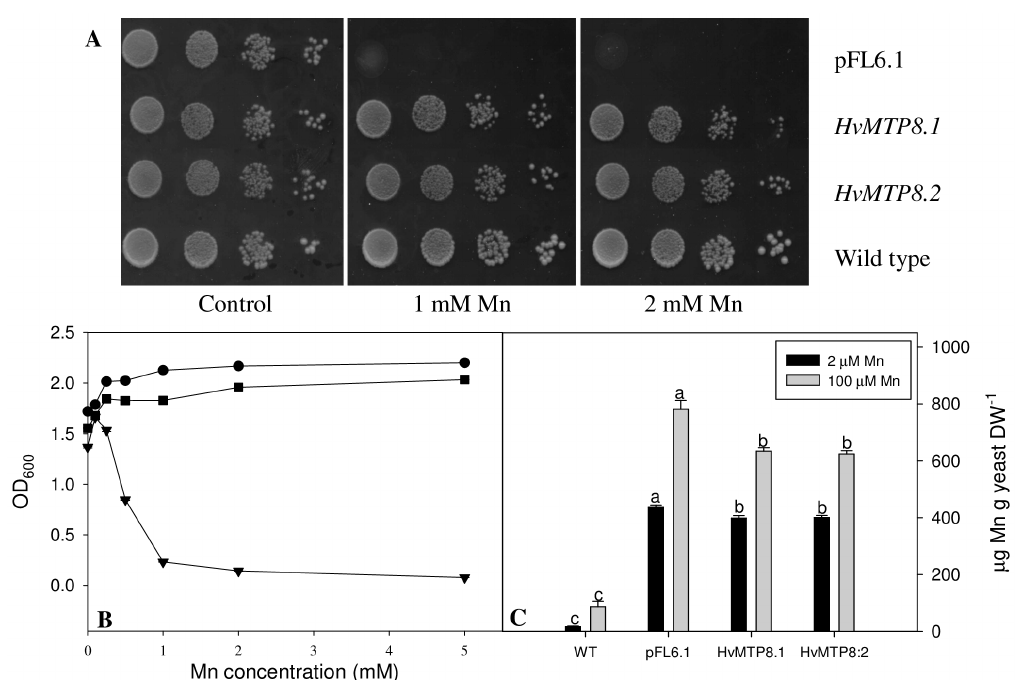
Fig. 2. Effect of MTP8.1 and MTP8.2 expression on Mn 2 + tolerance and Mn accumulation in the yeast mutant pmr1 D . Serial dilutions (1.0, 0.1 and 0.01 OD 600 ) of pmr1 cells transformed with MTP8.1 , MTP8.2 or empty vector (pFL6.1) were spotted on SD selective media with increased Mn content (A). Plates were incubated for 3-5 days at 30 ˚ C. The results are from one representative experiment out of three independent yeast transformations. Liquid yeast growth assay with MTP8.1 (circle), MTP8.2 (square) and pFL6.1 (triangle) transformed pmr1 D cells grown with increasing Mn concentrations over 48 hours, data are the means ¡ SE of three independent yeast samples (B). Mn accumulation in pmr1 D cells determined by ICP-OES analysis, cells were cultivated for 17 h with either 2.4 m M (black bars) or 100 m M (grey bars) Mn 2 + in medium (C). Data are the means ¡ SE of three independent yeast samples. Values with the same letter within the same treatment are not significantly different (P . 0.05).